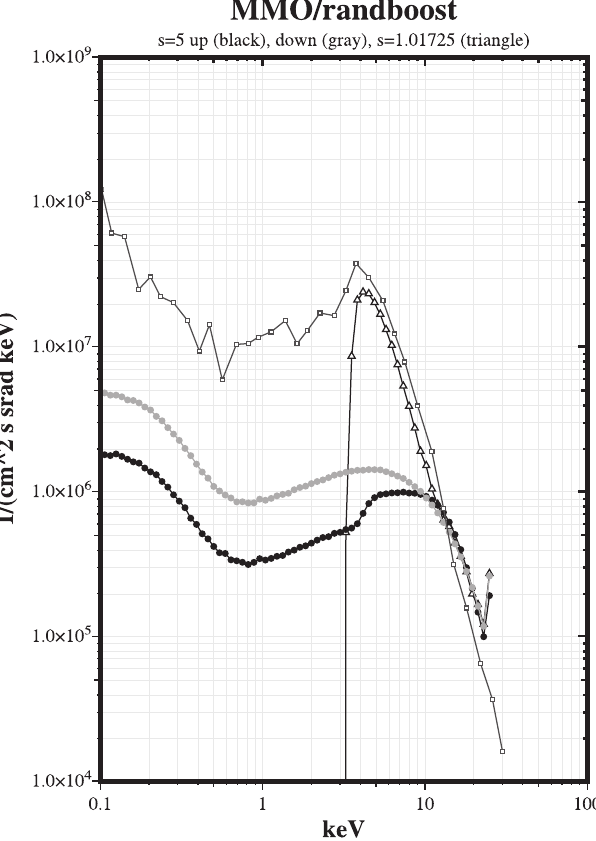
Fig. 16. MMO/randboost: same as model MMO/real (Fig. 15) but with random boosts included. The agreement is good